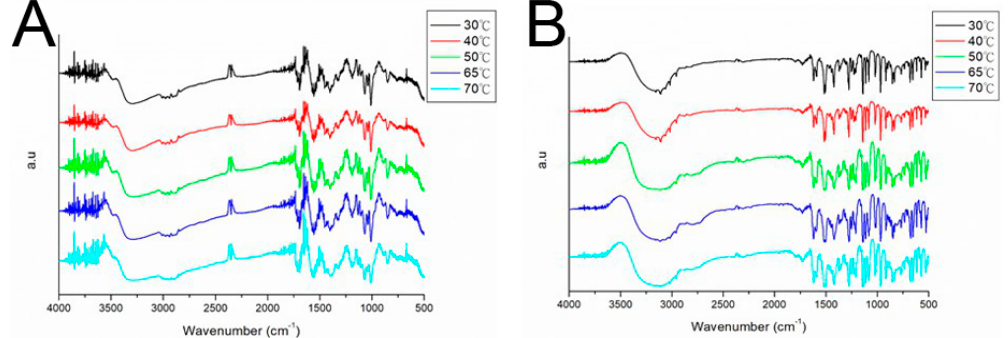
Figure 4. Effect of molding temperature on ( A ) amphotericin B and ( B ) fluconazole stability determined by Fourier-transform infrared spectroscopy.